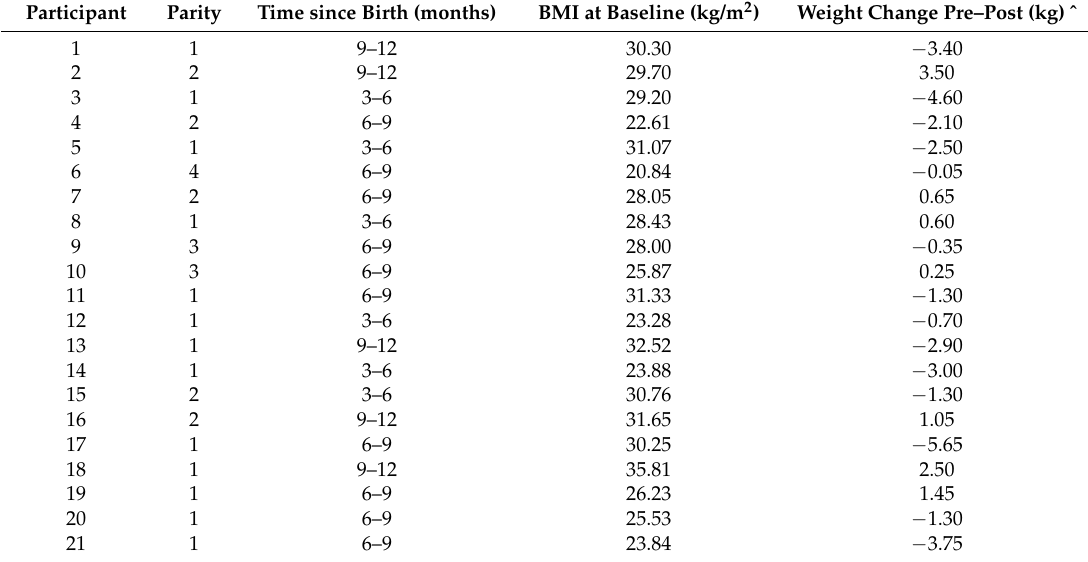
Table 2. Individual participant characteristics of women completing a post-intervention interview following Video-coaching to assist lifestyle (VITAL) change for mums.